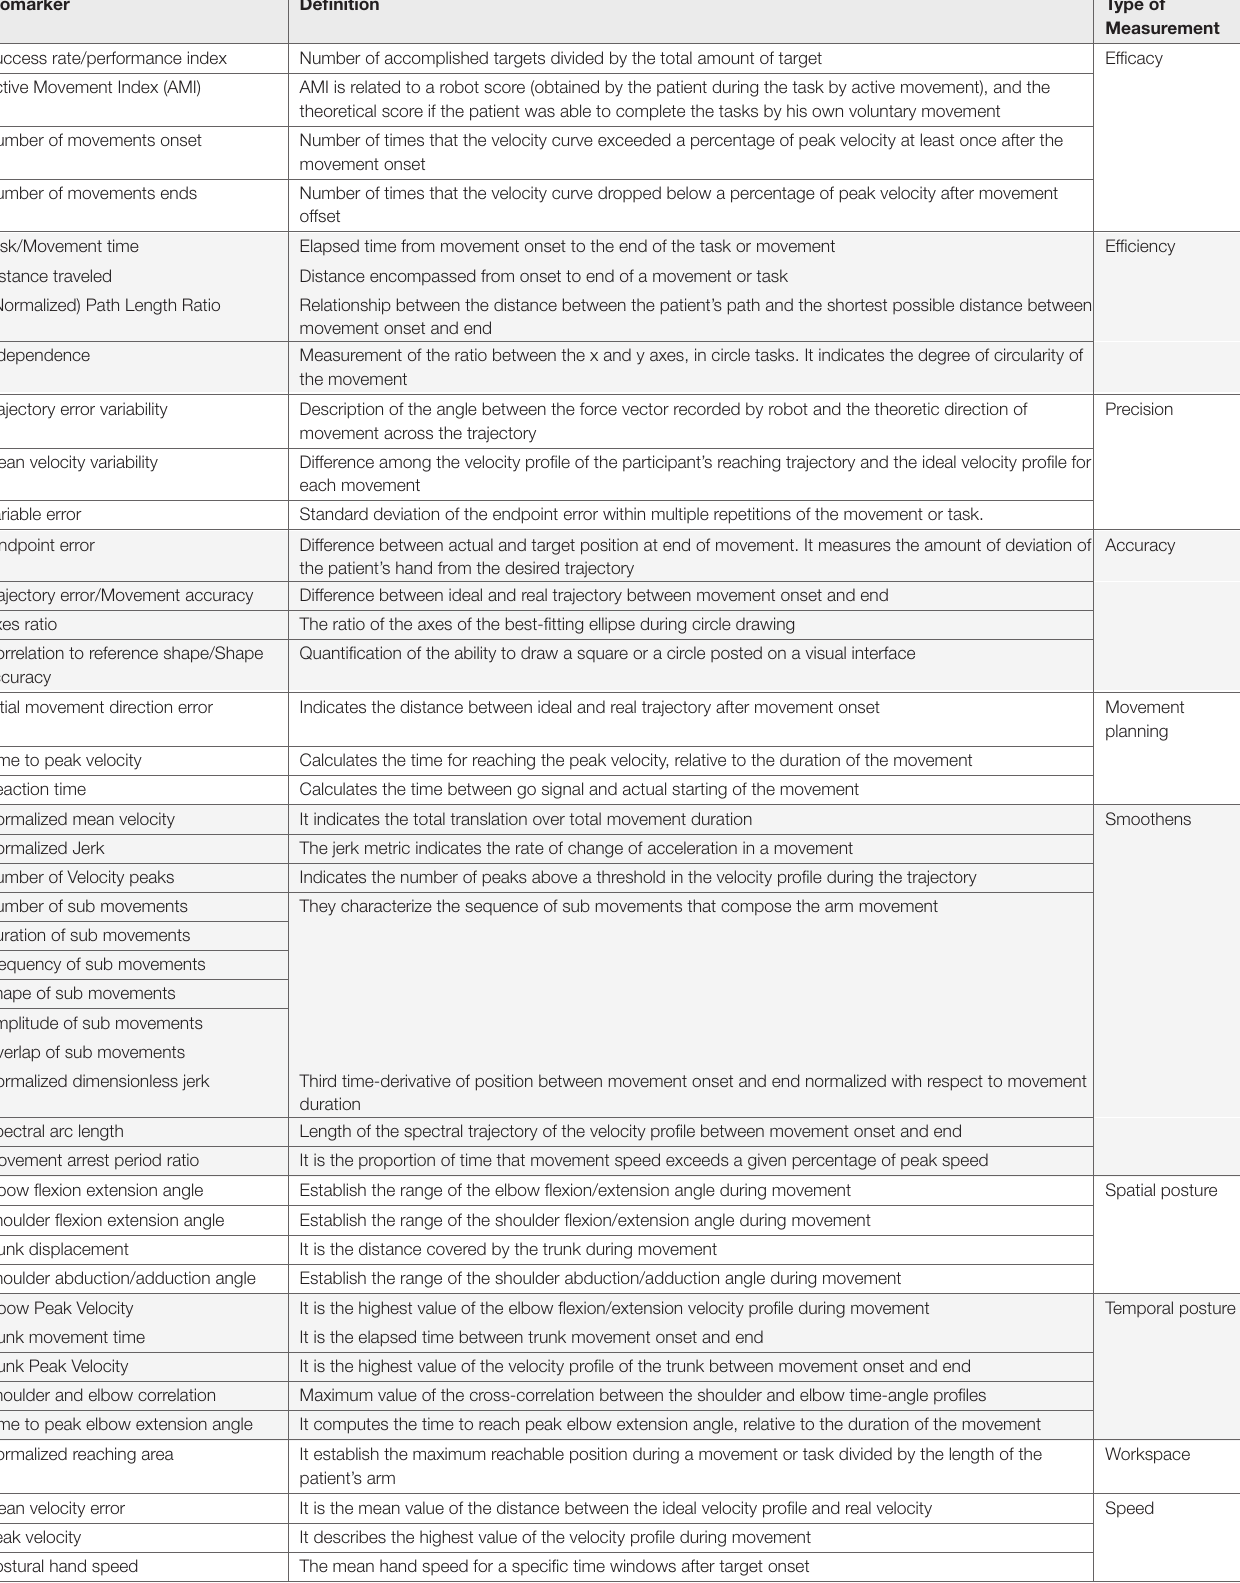
TABLE 3 | Kinematic-based biomarkers related to the motor rehabilitation focused on stroke.